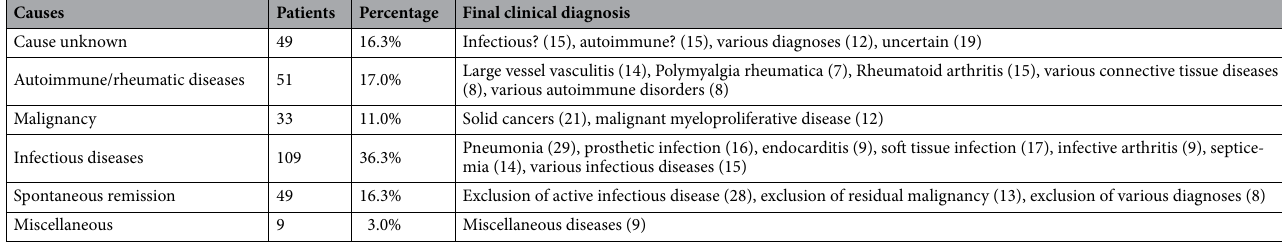
Table 2. Distribution and percentage of final clinical diagnoses and sub-groups.